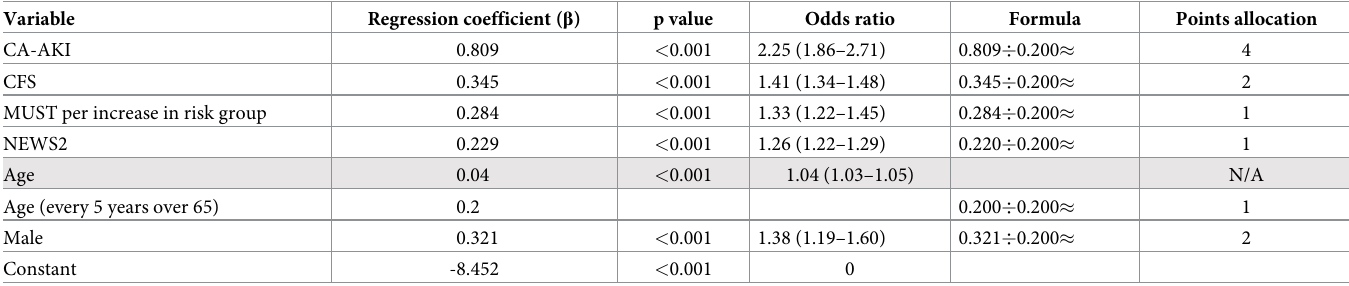
Table 2. Independent predictors of in-hospital mortality and points allocation.